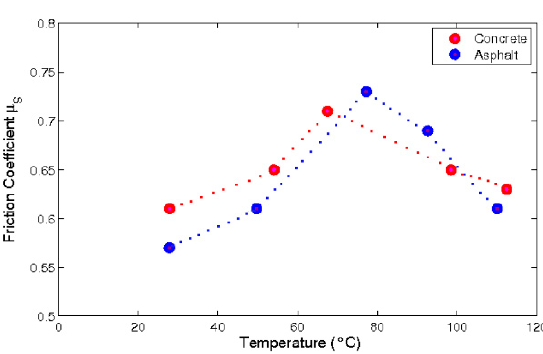
Figure 12. Friction coefficient µ s depending on the temperature and type of